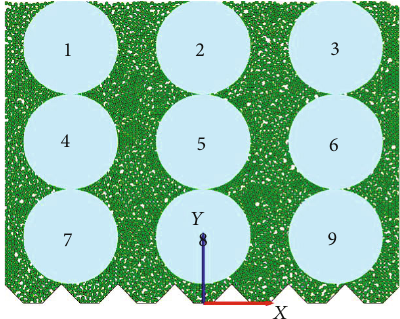
Figure 6: Position distribution of the measure circle.